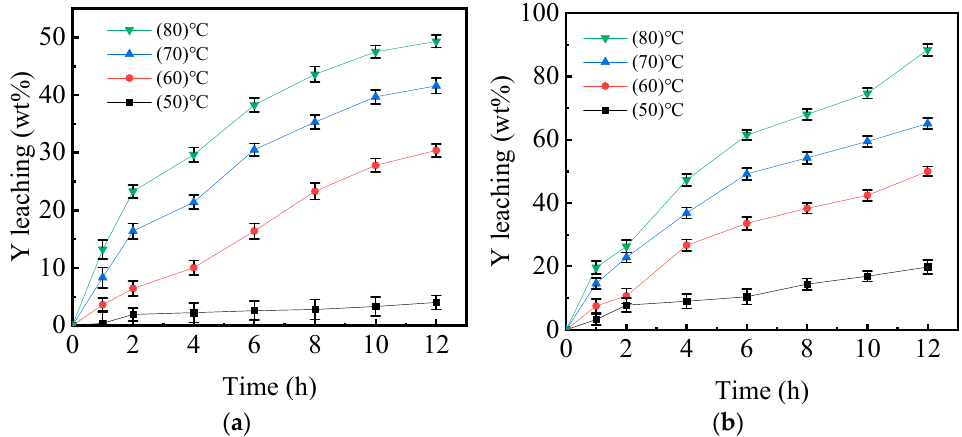
Figure 7. Effect of leaching time on the leaching efficiency of metallic yttrium in different activated samples at different reaction temperatures (T = 80 °C, t MA = 60 min). ( a ) Mechanically inactivated samples; ( b ) Mechanically activated samples.